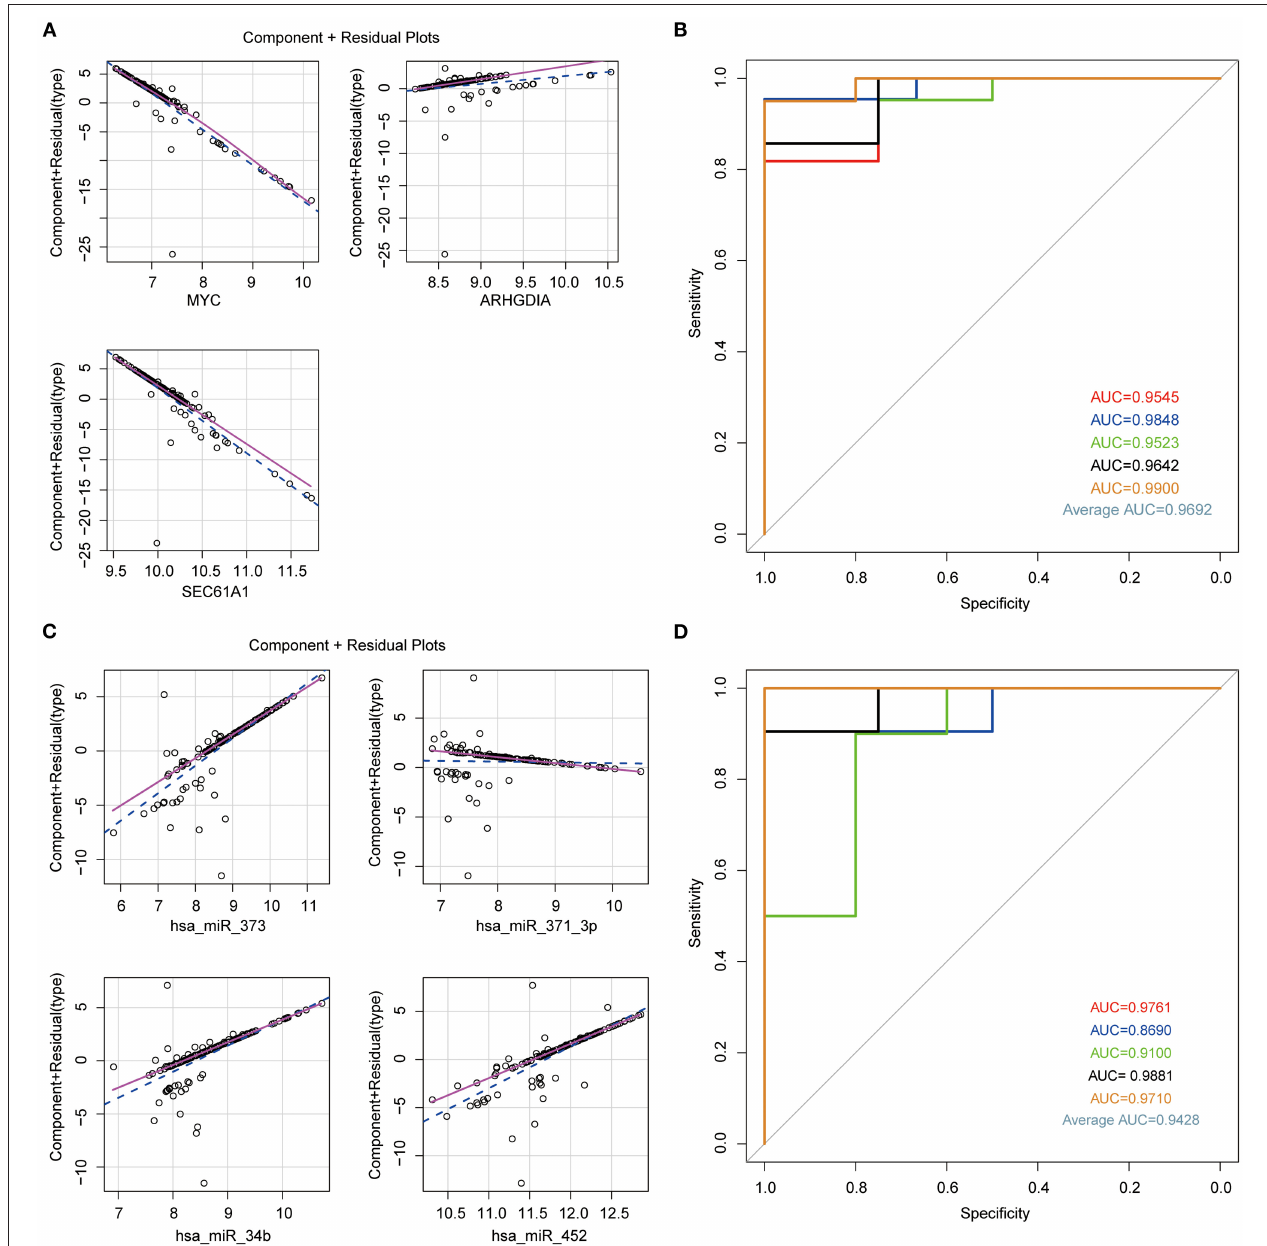
FIGURE 4 | Establishment of logistic regression model. (A) Component plus residual plot of ARHGDIA, SEC61A1, and MYC in the established model. Linear correlation between independent variables and dependent variables indicated the feasibility. (B) The ROC curve of predicted outcomes of GSE36961 by logistic regression model. The x axis represents false-positive rate (FPR), and the y axis represents true-positive rate (TPR). (C) Component plus residual plot of hsa-miR-373, hsa-miR-371-3p, hsa-miR-34b, and hsa-miR-452 in the established model. (D) The ROC curve of predicted outcomes of GSE36946 by logistic regression